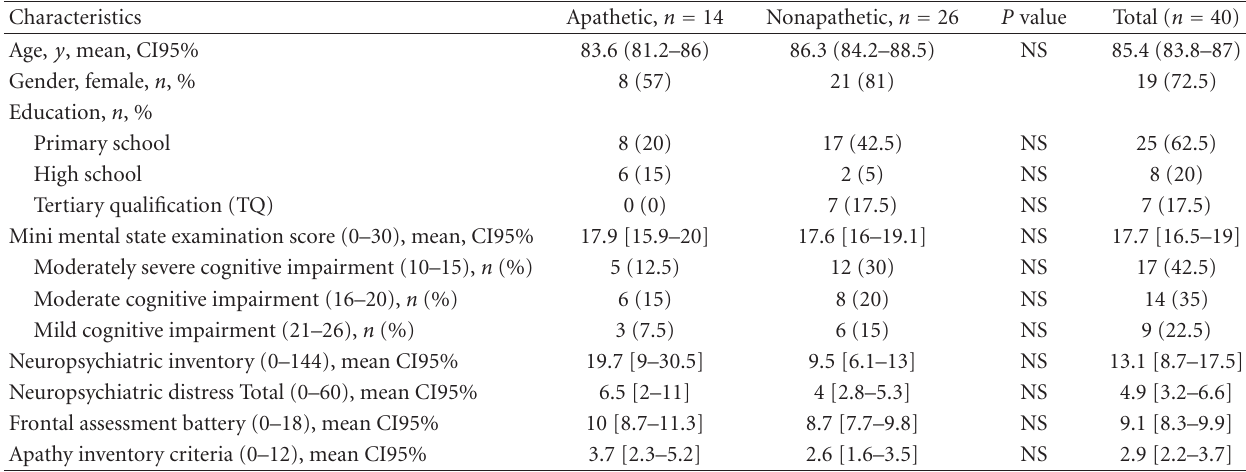
Table 2: Participant’s demographics and clinical characteristics.